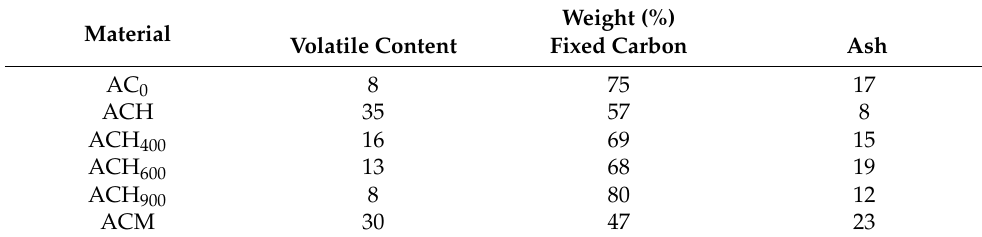
Table 4. Proximate analysis of the modified activated